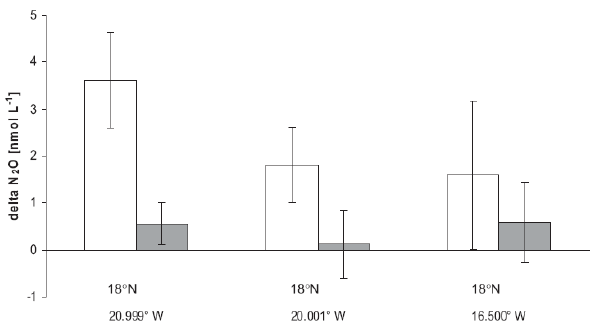
Fig. 6. N 2 O production determined from seawater incubations at three different stations (1–3) from the ETNA (P399). 1 N 2 O was calculated as the difference of N 2 O concentrations over the incuba- tion time (i.e. 24h). Open columns represent samples with no in- hibitor, filled columns represent samples with the archaeal inhibitor GC 7 . Error bars indicate the standard deviation of three technical replicates.